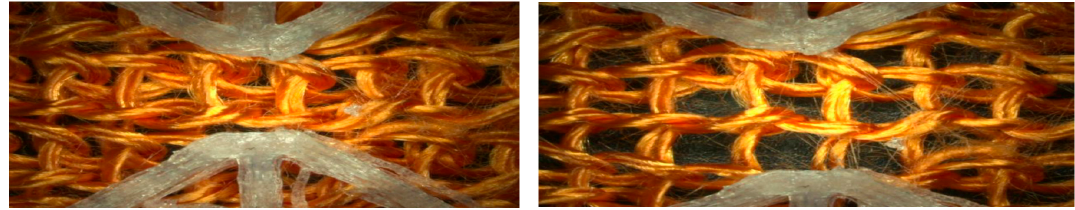
Figure 6. Microscopic pictures of the auxetic shape printed on a double-face fabric from acrylic/polyester, relaxed (left panel) and stretched (right panel) [82].